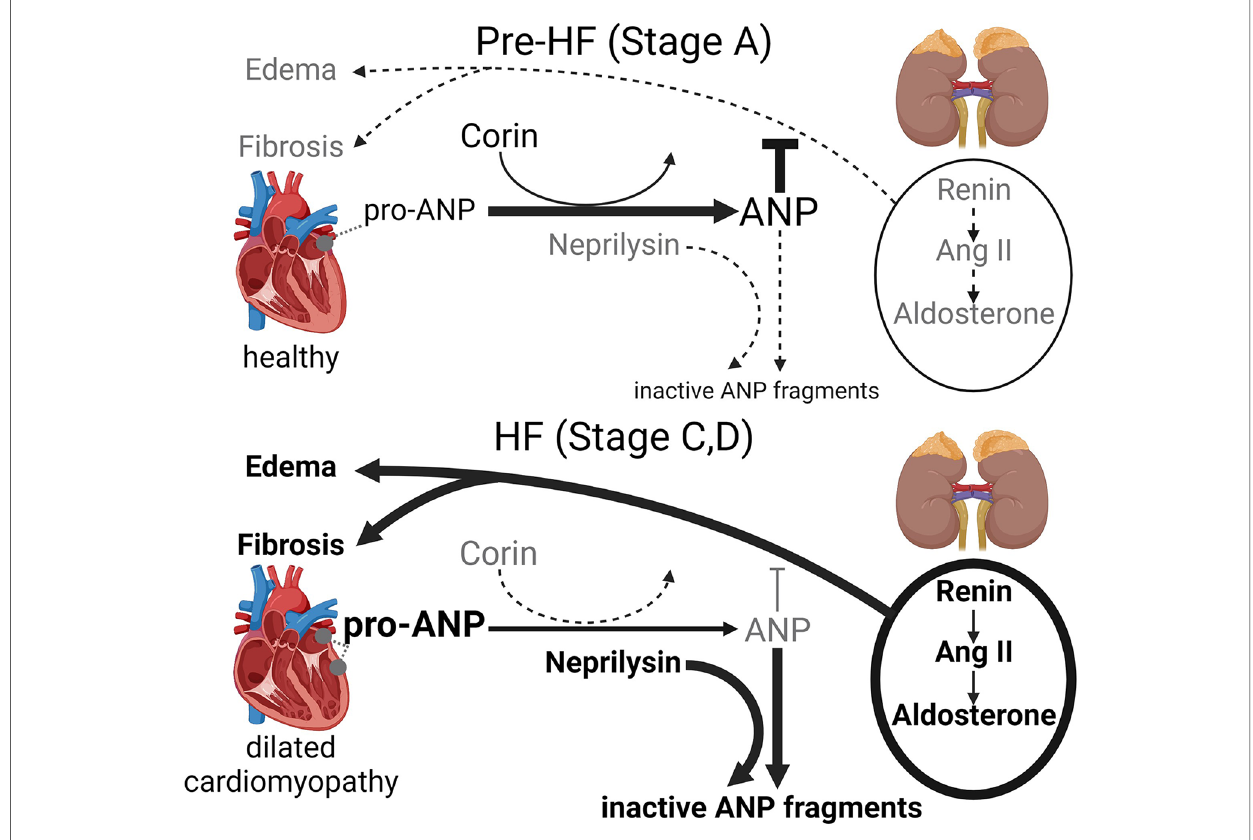
FIGURE 1 Schematic representation of the pathological shift of the cardiac corin-atrial natriuretic peptide (ANP) axis and classical RAAS [renin-angiotensin II (Ang II) — aldosterone] axis in dilated cardiomyopathy, which promotes cardiac fi brosis, edema and accelerates HFrEF